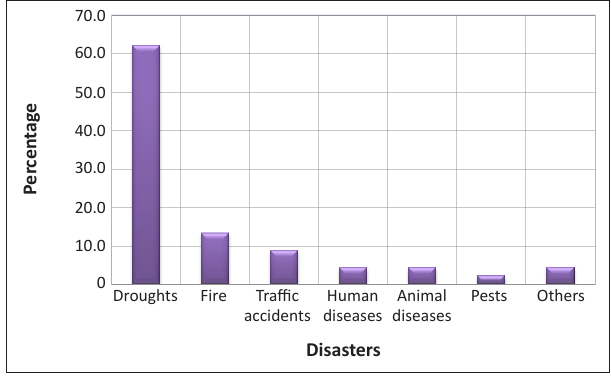
FIGURE 4: How disaster knowledge was gained.